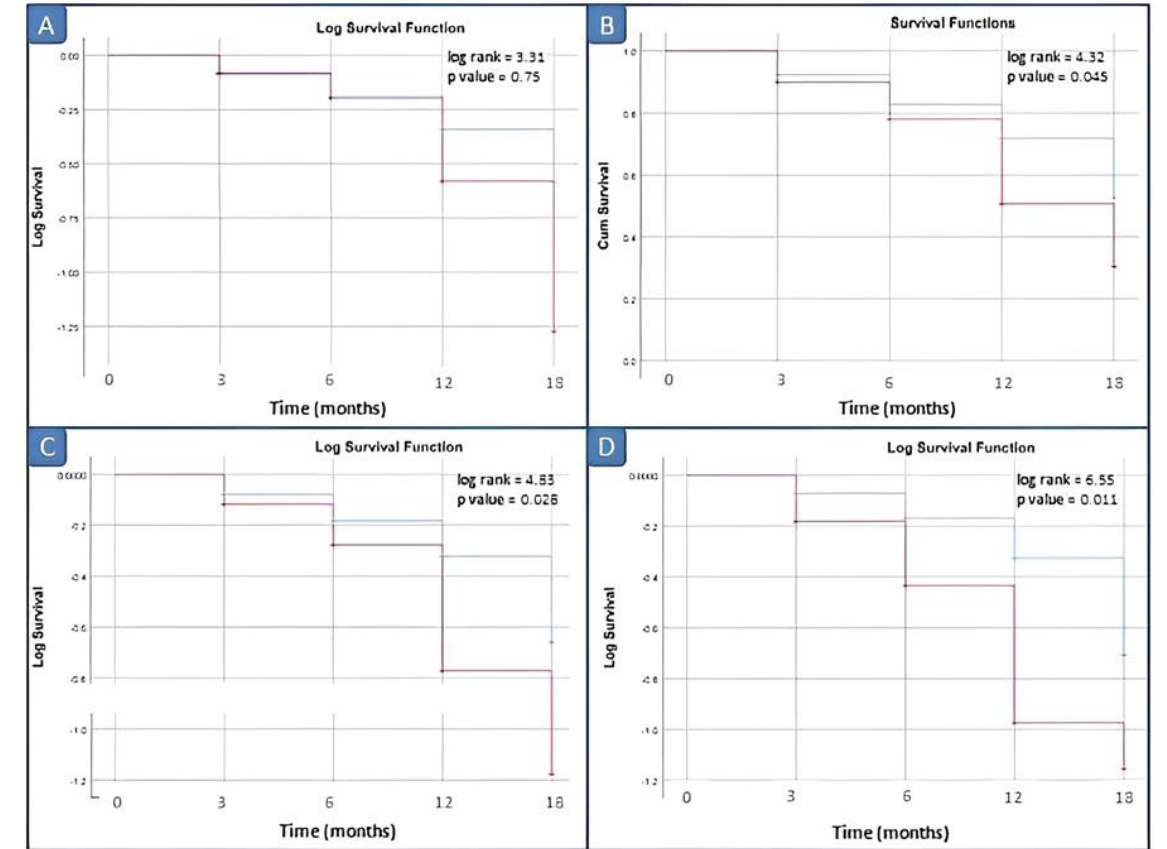
Figure 4. Survival analysis in inactive JIA patients by different cut-off values of calprotectin. ( A ) Cut-off of 10 ng/mL; ( B ) cut-off of 12 ng/mL; ( C ) cut-off of 15 ng/mL; and ( D ) cut-off of 20 ng/mL. Red line: positive patients, i.e., basal calprotectin value ≥ cut off; blue line: negative patients, i.e., basal calprotectin value <cut off.